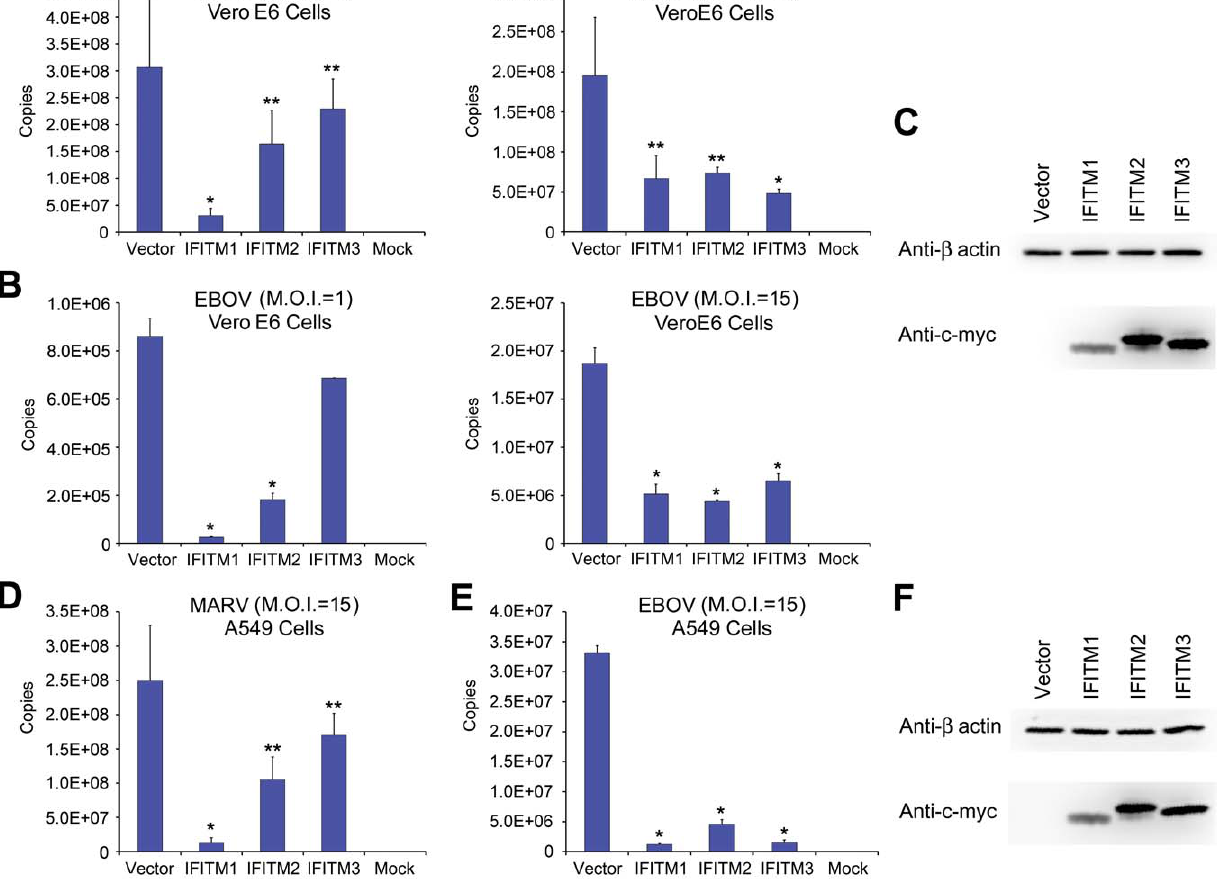
Figure 2. Replication of infectious MARV and EBOV is restricted by IFITM1, 2, and 3. Vero E6 cells transduced to express the indicated c- myc-tagged IFITM proteins or with vector alone were incubated with infectious ( A ) MARV or ( B ) EBOV at indicated MOIs for 1 hour and then maintained in growth medium. After 72 hours, culture supernatant was harvested and viral titer was assayed using quantitative RT-PCR. A single asterisk indicates a significant difference with controls cells ( P , 0.05); double asterisks indicate P , 0.1. ( C ) IFITM protein expression in Vero E6 cells was assayed by western blot using anti-c-myc antibody. ( D ) and ( E ) are experiments similar to those in (A) and (B), except A549 cells transduced to express the indicated c-myc-tagged IFITM proteins or with vector alone were used. ( F ) IFITM protein expression in A549 cells was assayed by western blot using anti-c-myc antibody. Each panel represents two experiments with similar results.